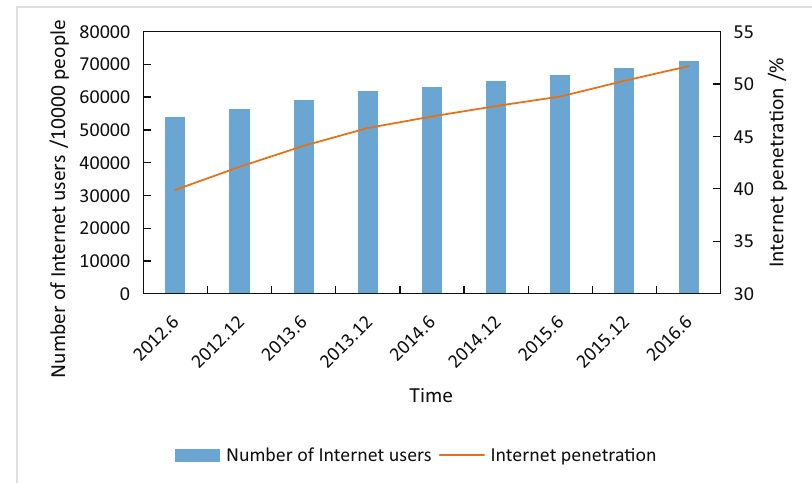
Figure 1: Development of Internet users in China from June 2012 to June